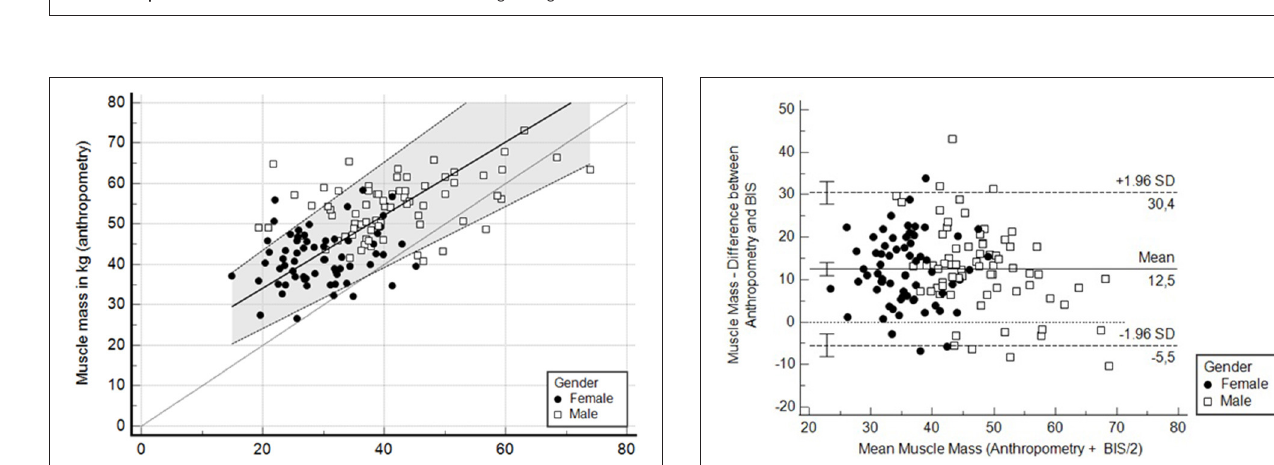
FIGURE 3 | Concordance between the score used for diagnosing PEW.